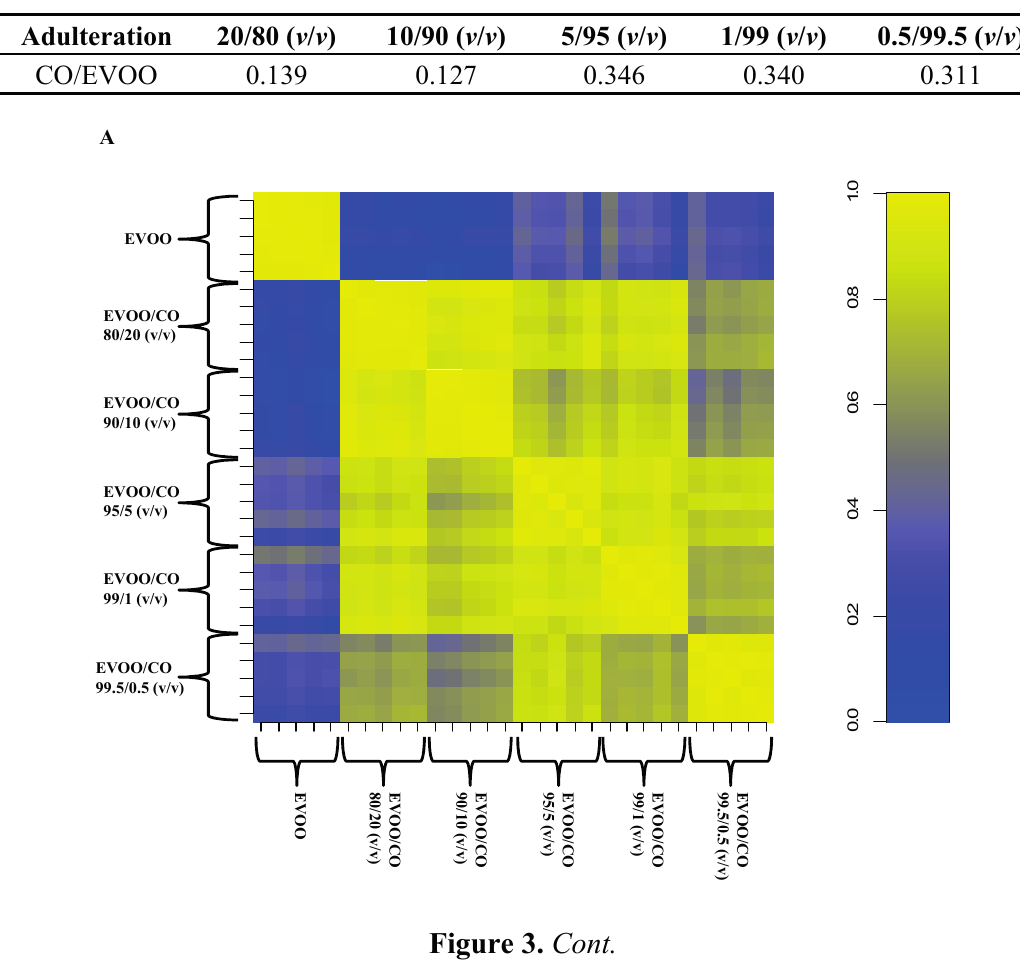
Table 1. Mean Pearson’s correlation coefficients of different adulteration percentages (CO adulteration of EVOO).